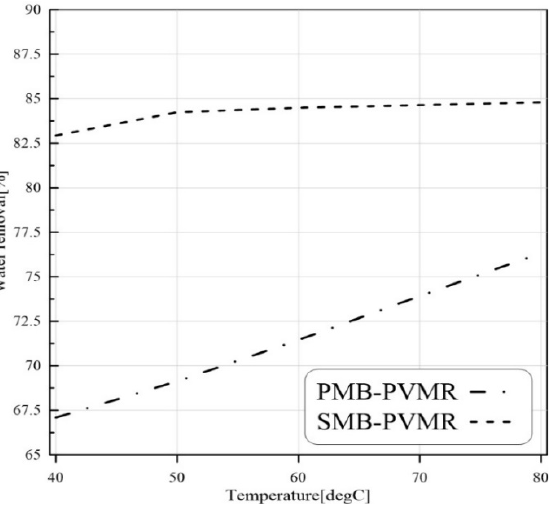
Figure 11. Comparison of water removal in MB-TR, PMB-PVMR, and SMB-PVMR based on variations in temperature. Et/LA: 1, feed flow rate: 10 mm 3 /s, and W: 8.6 g.